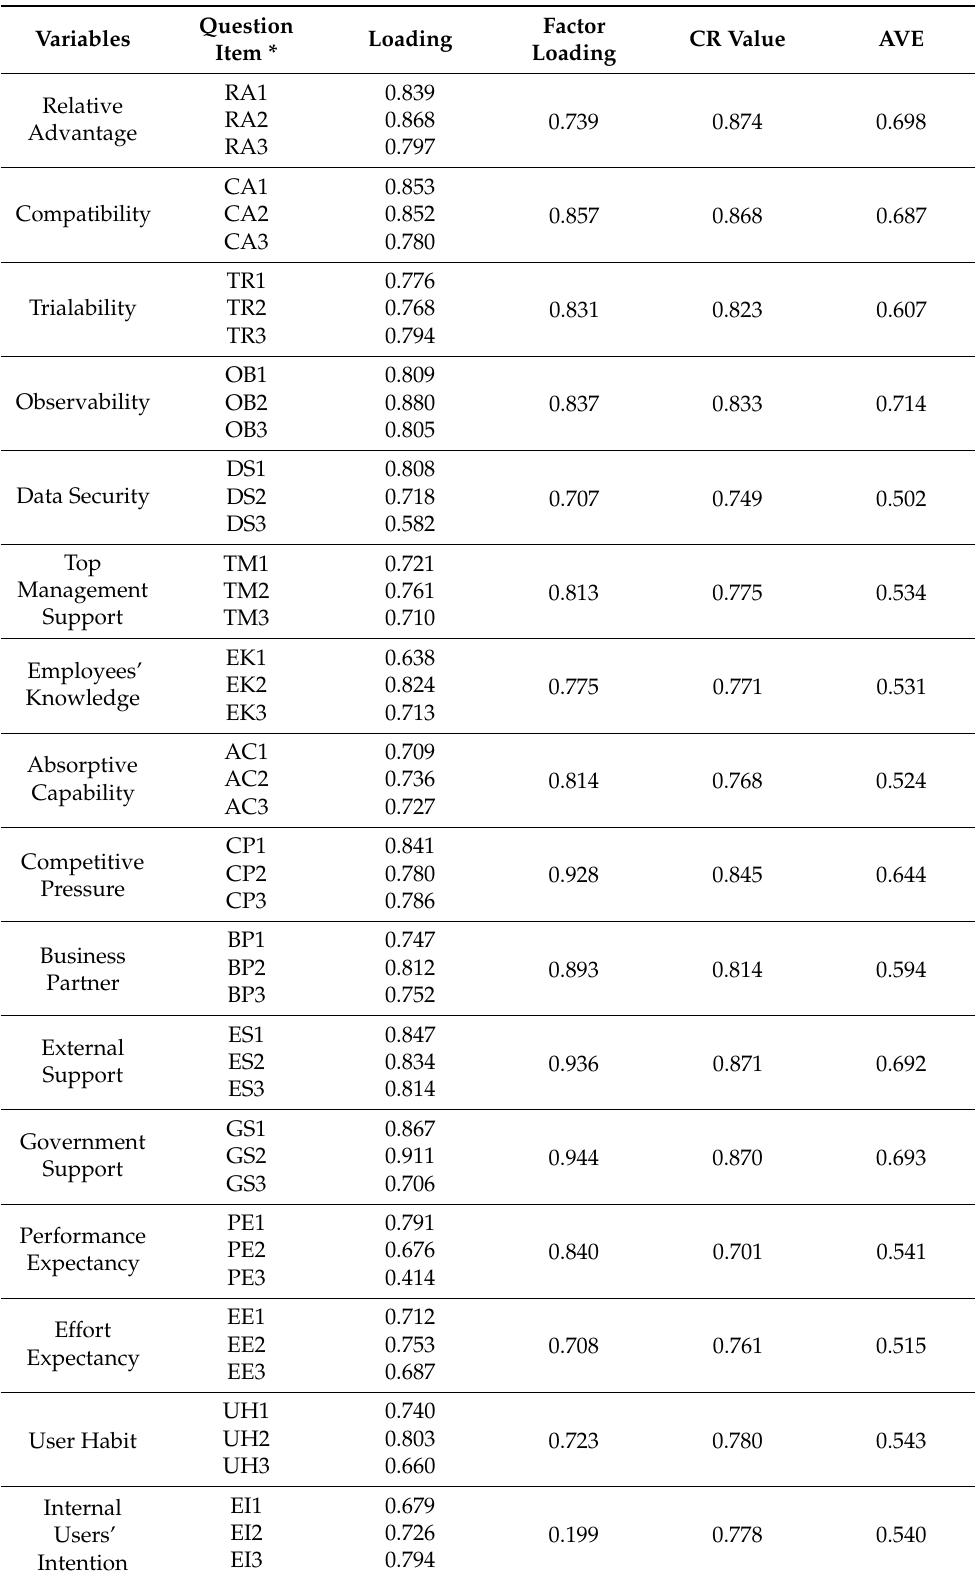
Table 3. Measurement of potential variables of loadings, CR value and